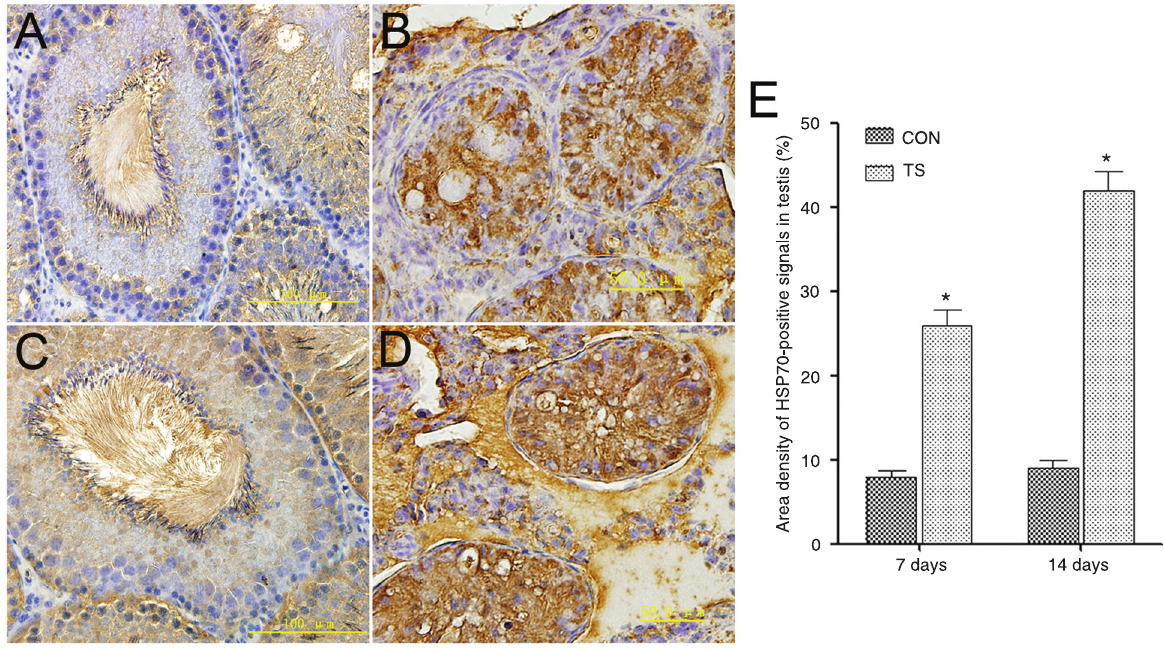
Figure 4. Localization and quantification of HSP70 by immunostaining. HSP70 in the control (CON) groups ( A , control group for 7 days; C , control group for 14 days) and tail-suspended (TS) groups ( B , TS group for 7 days; D , TS group for 14 days) was detected us- ing rabbit anti-HSP70 antiserum, biotinylated second antibody and horseradish peroxidase-labeled avidin chain working fluid. E , The area density of positive substance was obtained by dividing the area of positive signals by the area of one field under the microscope with combined magnification of 400X. *P < 0.01 compared to control (one-way ANOVA and Tukey